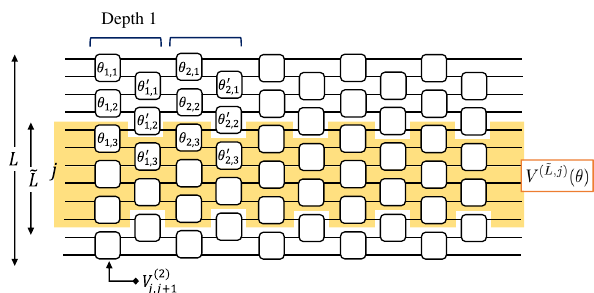
FIG. 3. The brickwork-structured ansatz V ( L ) (θ) , defined by Eq. (22). For translationally invariant systems, we choose the variational parameter set θ = { θ i , k , θ (cid:16) respectively, become independent of the position k . The yel- low region represents the j -centered ˜ L -size domain (cid:4) ( ˜ L , j ) , which is utilized for the composition of the restricted ansatz V ( ˜ L , j ) (θ) based on Eq.